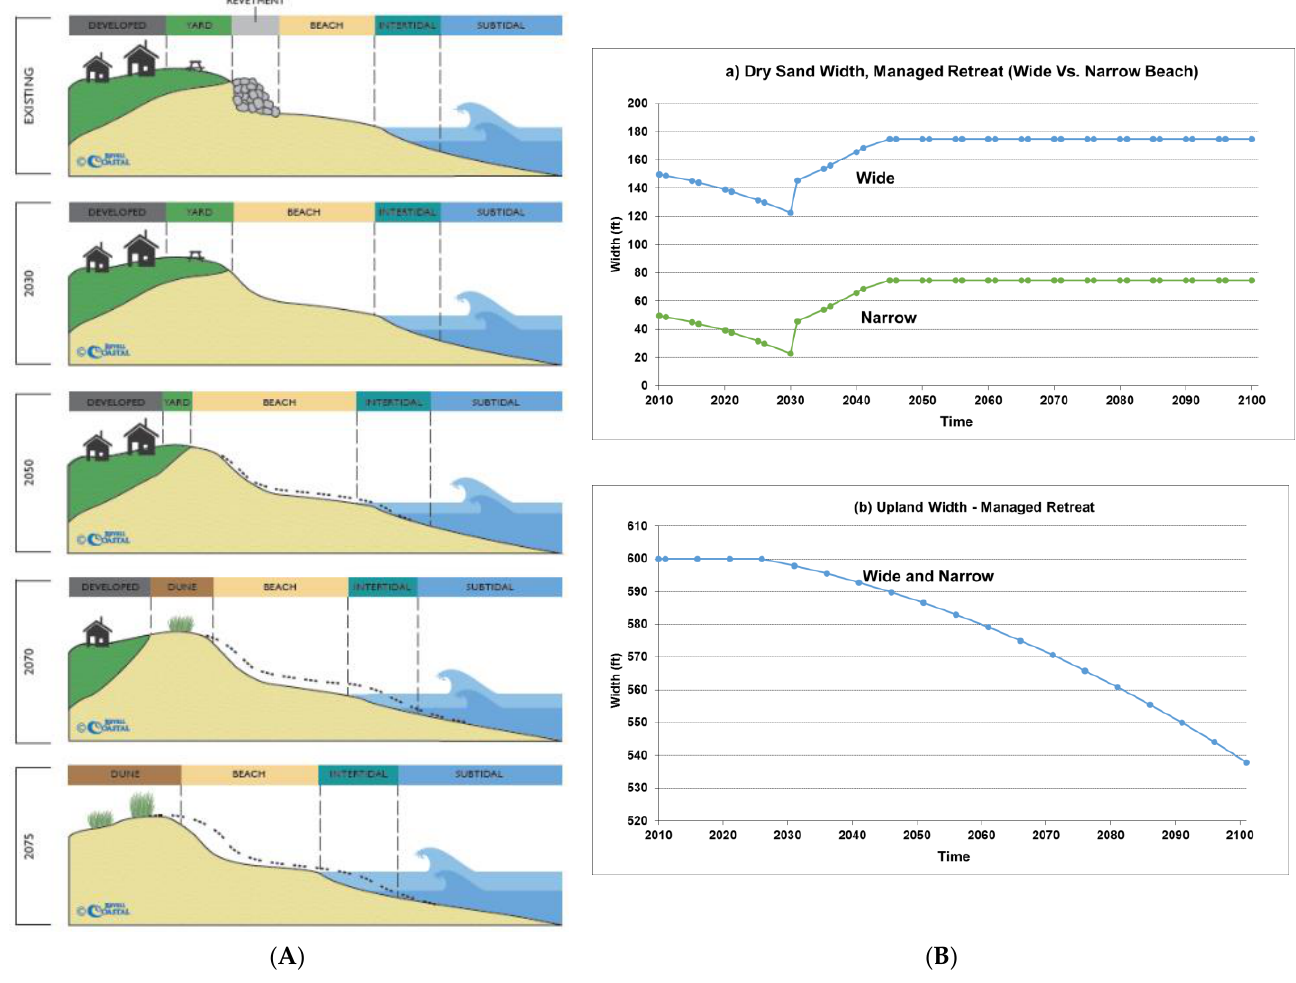
Figure 12. ( A ) Managed retreat adaptation follows removal of existing coastal armoring in 2030, with coastal erosion damaging private property while allowing beaches to migrate inland and maintain their public recreation and natural values. ( B ) Dry sand beach width over time with armoring (wide vs. narrow beach) (Ba top plot); upland width over time with armoring (wide vs. narrow beach) (Bb bottom plot).